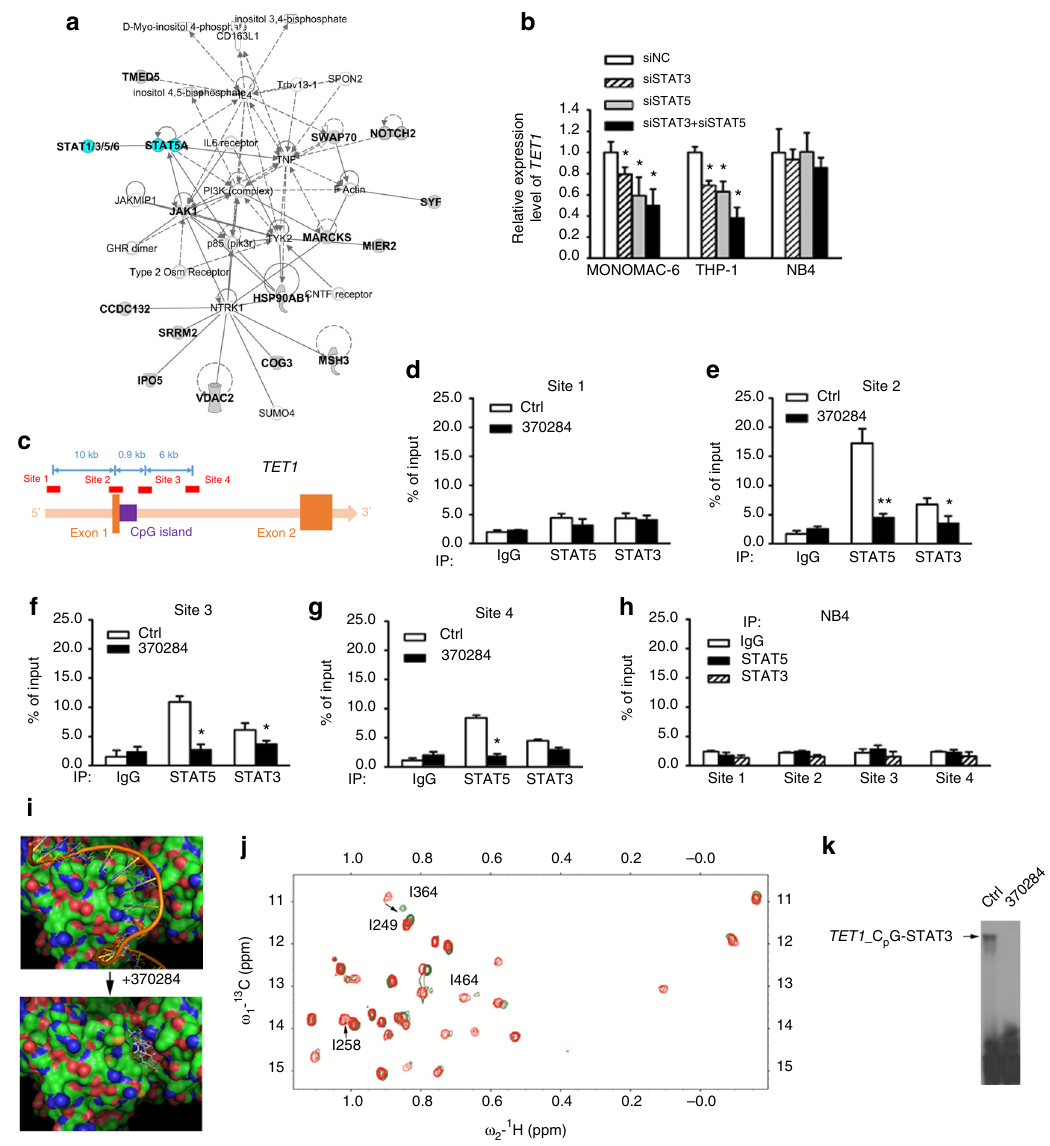
Fig. 3 STAT3 and STAT5 are potential direct targets of NSC-370284 in AML. a A top network identi fi ed with IPA involving all the 14 genes carrying recurrent mutations in THP-1 NSC-370284-resistant clones. Genes with mutations are labeled in bold font. b Knockdown of STAT3 and/or STAT5 reduces TET1 level. MONOMAC-6, THP-1, and NB4 cells were electroporated with control siRNA (siNC), si STAT3 , si STAT5 or a combination of si STAT3 and si STAT5 . TET1 expression level was detected by qPCR 48 h post transfection. c Four genomic sites designed for ChIP-qPCR analysis to identify potential binding sites of STAT3 and STAT5 on TET1 promoter and other regions. d – h MONOMAC-6 cells ( d – g ), were treated with DMSO control or 500 nM NSC- 370284. ChIP-qPCR assay was carried out 48 h after drug treatment. Enrichment of STAT3, STAT5, or IgG at the TET1 promoter region and other regions are shown. NB4 cells ( h ), were applied as a negative control. i Predicted binding of DNA (upper panel) or NSC-370284 (lower panel) with the DNA- binding domain (DBD) that is conserved between STAT3 and STAT5 proteins, from docking study on PDB ID 1bg1 using MolSoft ICM. j The association between STAT3 and NSC-370284 as determined with NMR chemical shift perturbation (CSP). Complex formation with compound 370284 induced extensive CSPs at the Ile residues of STAT3 at 1:2 of protein:ligand molar ratio (red peaks: free STAT3; green peaks: STAT3-NSC-370284 complex). The CSP occurs at residues adjacent to the DNA-binding site (I464), and residues at or near the DBD. k NSC-370284 suppresses the binding between STAT3 and TET1 CpG island, as determined through EMSA. * P < 0.05; ** P < 0.01, two-tailed t -test. Error bar indicates SD of triplicate